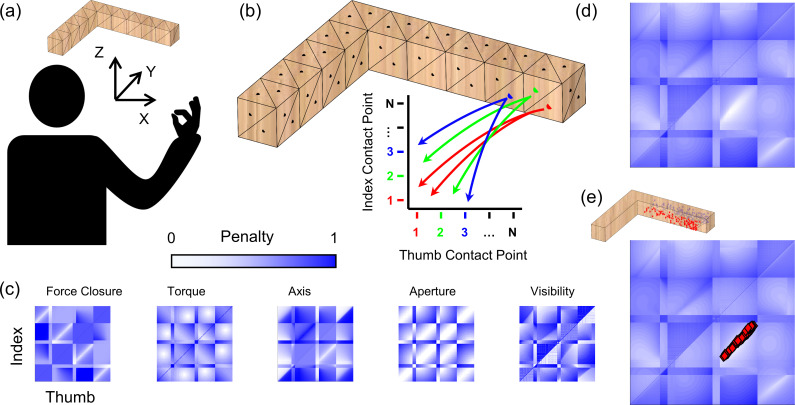
A framework that unifies distinct aspects of grasp selection.(a) Mesh model of object in same 3D reference frame as participant poised to execute grasp. (b) Discrete sampling of the reachable surface defines a 2D space containing all potential combinations of index and thumb contact points on the object. (c) Color-coded maps showing penalty values for each potential grasp for each penalty function. (d) Overall penalty function computed as the linear combination of maps in (c). (e) Human grasps projected into 2D penalty-function space neatly align with minimum of combined penalty map.